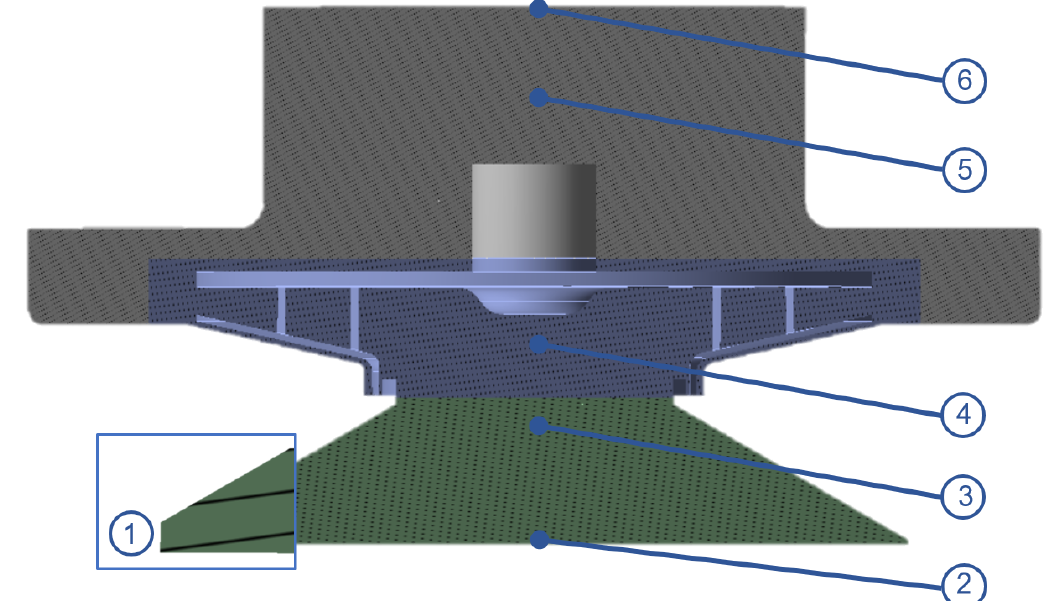
Figure 7. Suction cup Flow domains: ( 1 ) Inlet, ( 2 ) Surface wall, ( 3 ) Suction cup cavity, ( 4 ) Impeller rotational domain, ( 5 ) Casing and ( 6 )